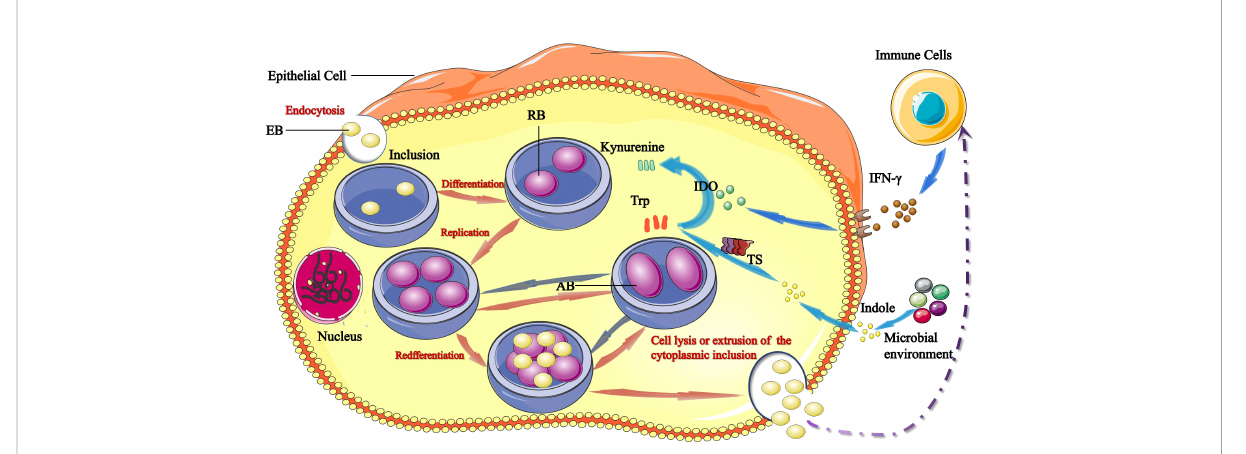
FIGURE 1 Links between tryptophan/IFN- g axis and C. trachomatis . The infectious form of C. trachomatis , elementary bodies (EBs) infect epithelial cells via endocytosis. Upon entry, EBs differentiate into reticulate bodies (RBs) and start replicating within the inclusion. RBs divide by binary fi ssion, and consequently grow until the entire cytoplasmic matrix is fi lled and the nucleus is dislocated. After 24 – 74 hours, RBs redifferentiate into EBs, EBs are released by host cell lysis and/or the extrusion of inclusion to initiate a new infection cycle. IFN- g induces production of IDO1, which catabolizes tryptophan into kynurenine. Tryptophan starvation can lead to RBs turn into aberrant bodies (ABs). The chlamydial tryptophan synthase (TS) gene converts indoles produced by other microbiota back into tryptophan. Persistent C. trachomatis can become infectious and re-enter the life cycle by converting indole into tryptophan via